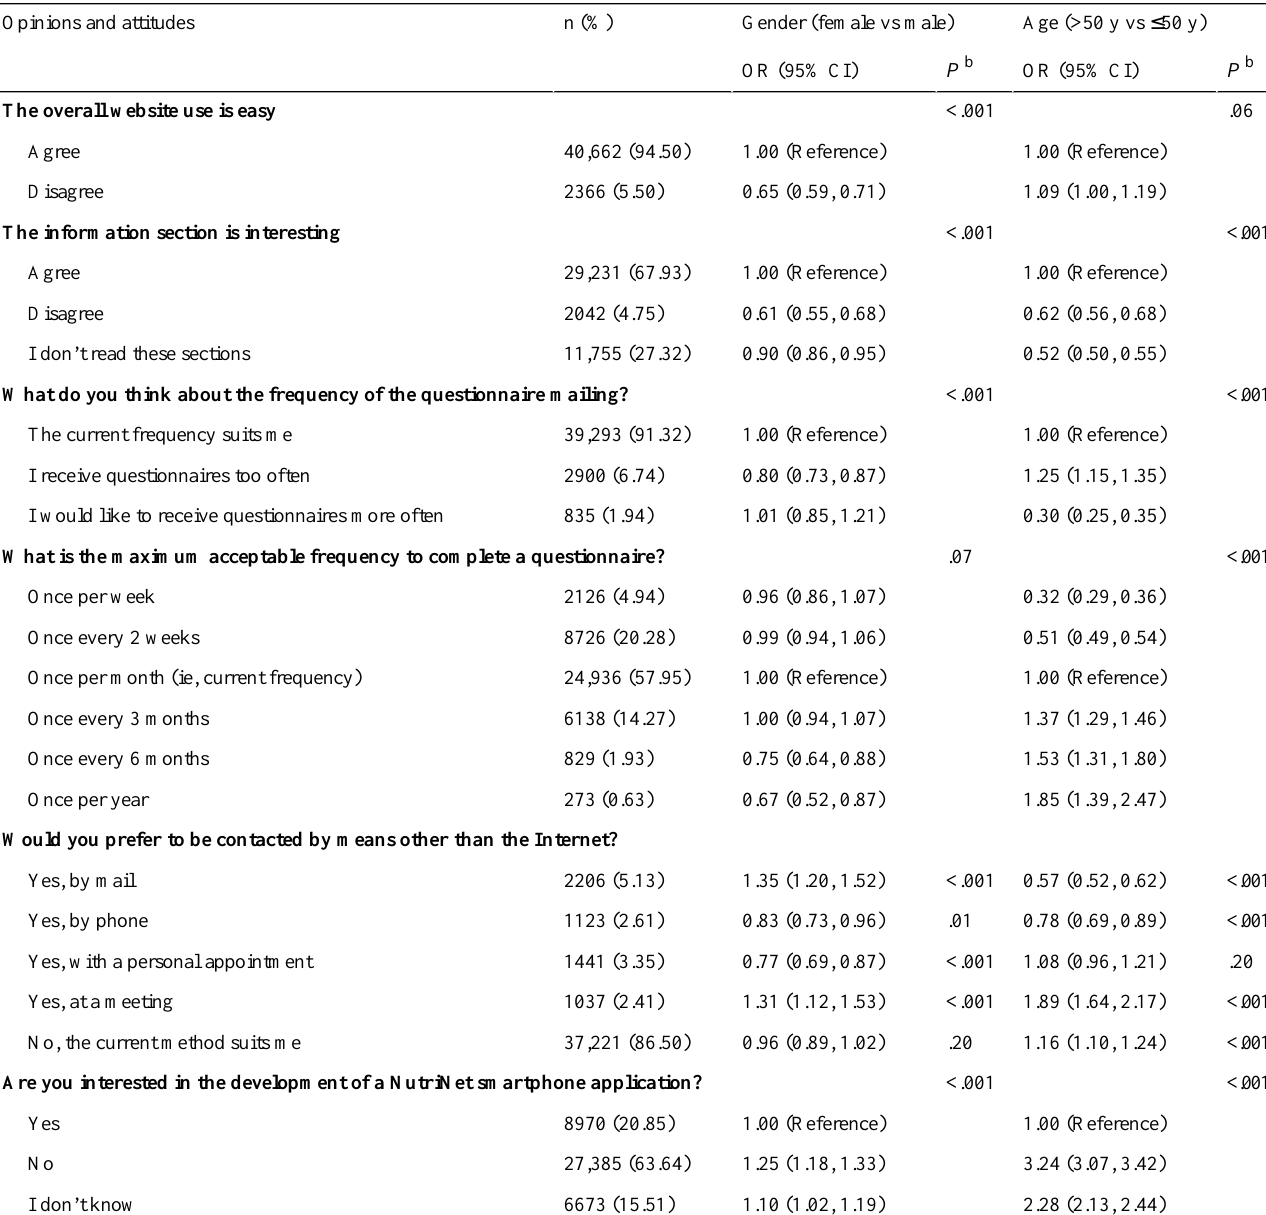
Table 3. Opinions and attitudes toward the NutriNet-Santé Study demands according to gender and age, NutriNet-Santé Study, France, 2013. a